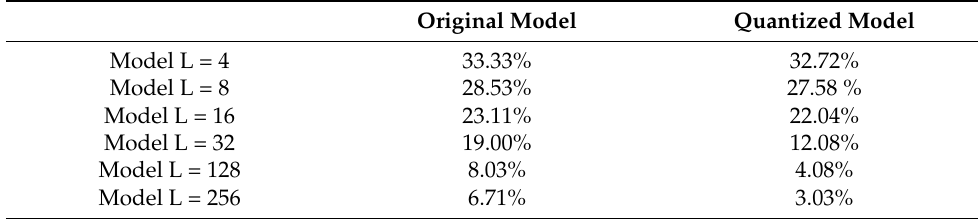
Table 7. Model accuracy before and after